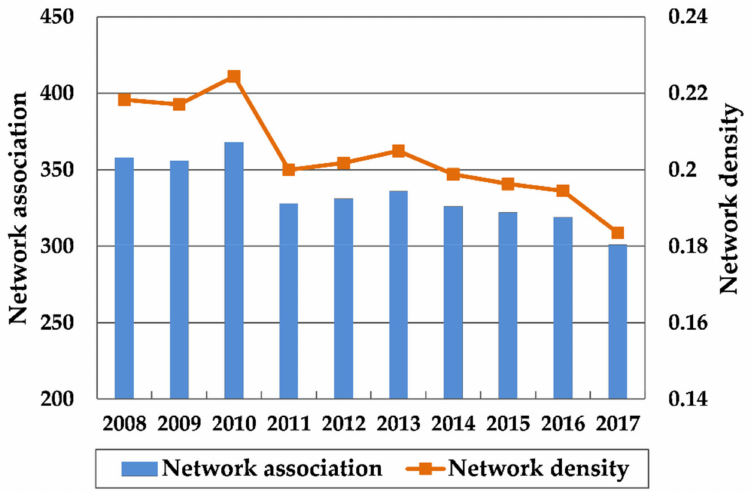
Figure 5. Network association and network